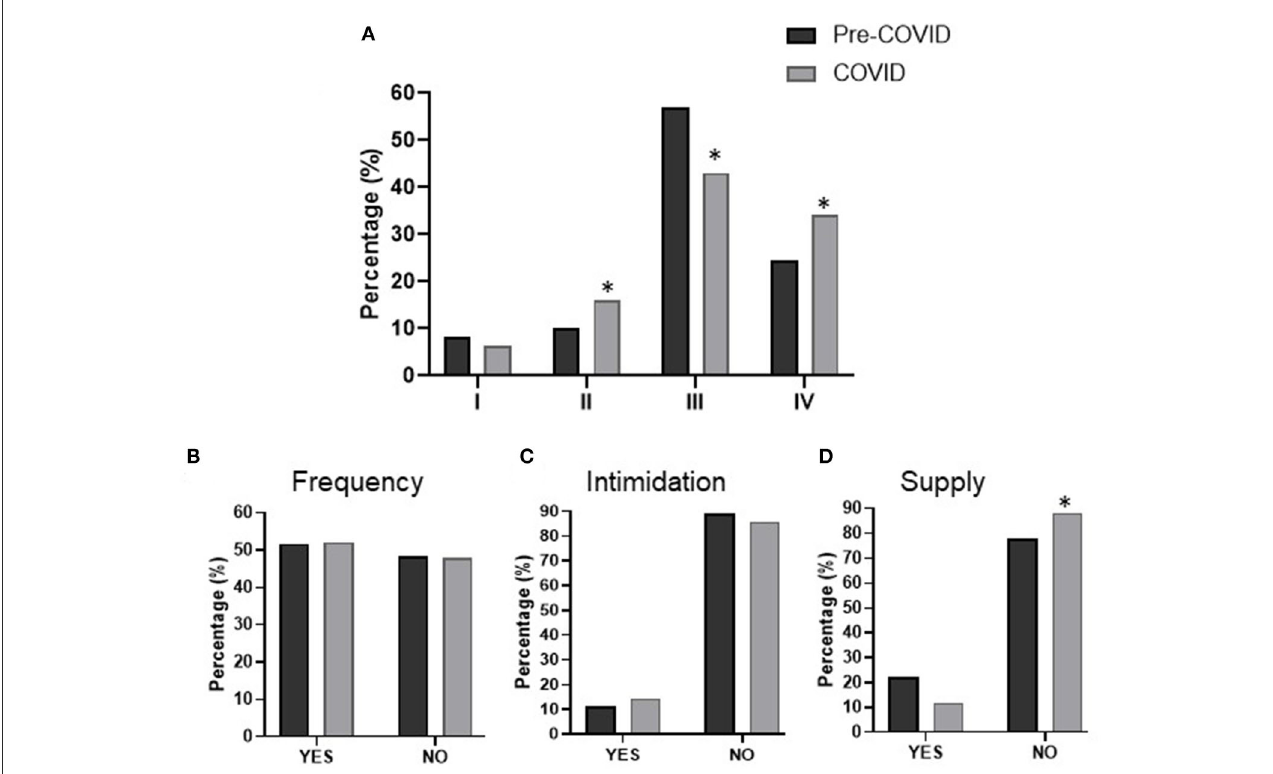
FIGURE4 Drug-requesting behavior of patients. Distribution of participants according to (A) type of request, (B) frequent request, (C) use of intimidation, and (D) supply of medicine. Requesting types are as follows: I. prescriptions corresponding to an over-the-counter (OTC) drug; II. formal prescription; III. without prescription; IV. Forged prescriptions. Statistical differences: * p < 0.05 pandemic vs . pre-pandemic.